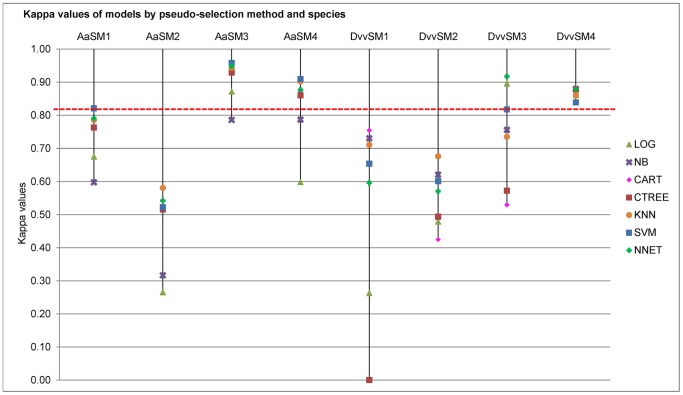
Kappa values of models for the four pseudo-absence selection methods and two species datasets.
Aa = A. albopictus, Dvv = D. v. virgifera, values above the red broken line are in the excellent band of the kappa index.